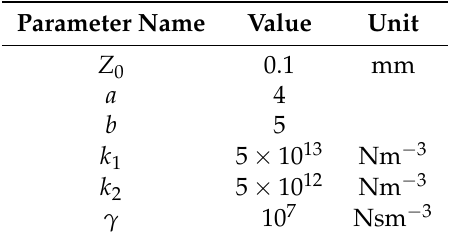
Table 2. Model parameters of the nonlinear delamination.